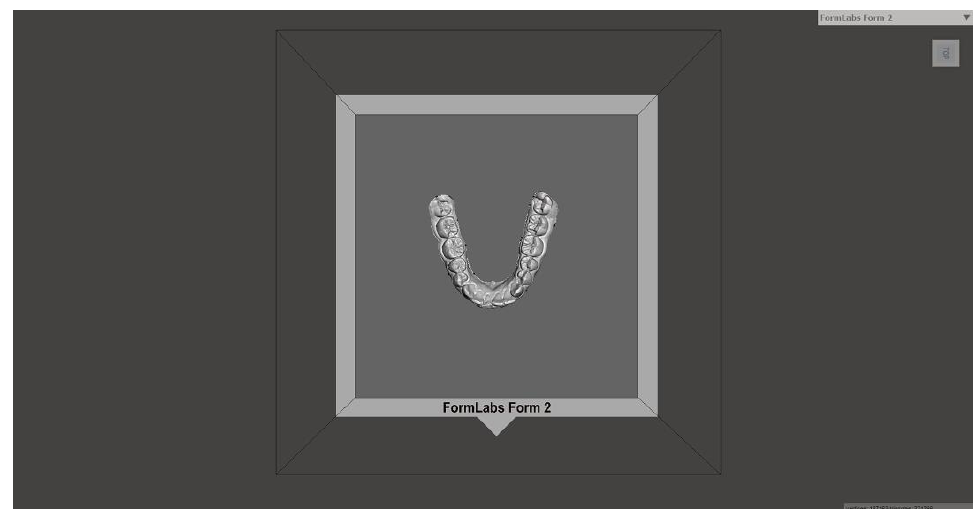
Figure 5. The model is uploaded into 3D printer PreForm (Formlab, Somerville, MA, USA) for setting 3D printing parameters and slicing the digital model for final prototyping process.